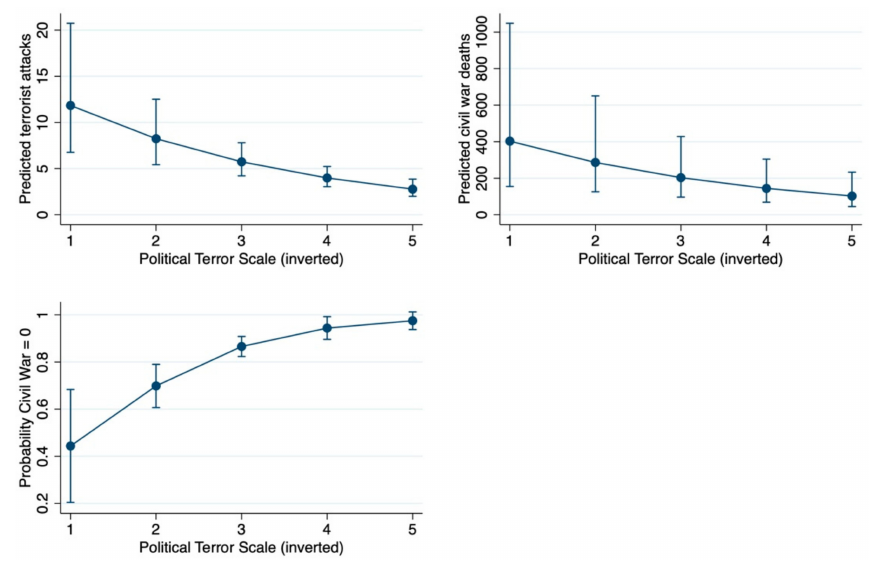
Figure 3. Political terror scale and conflict 95% CIs.